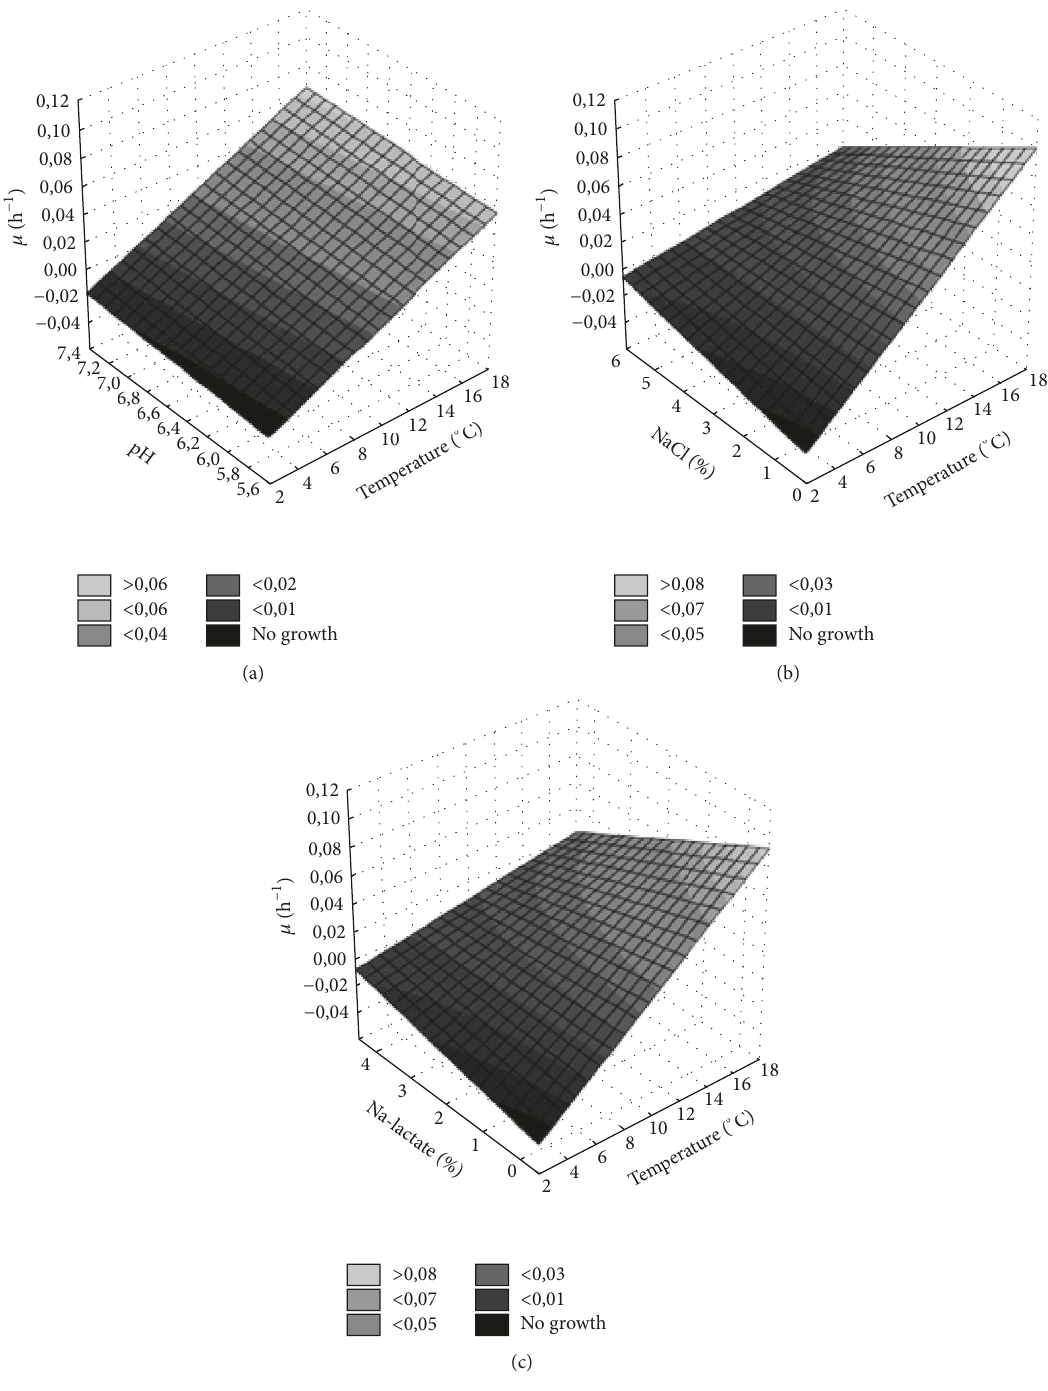
Figure 1: Response surfaces for the growth rate ( 𝜇 , h −1 ) of L. plantarum , as a function of temperature and pH (a), temperature and NaCl (b), and temperature and Na-lactate (c) (temperature and salts are given in ∘ C and %,